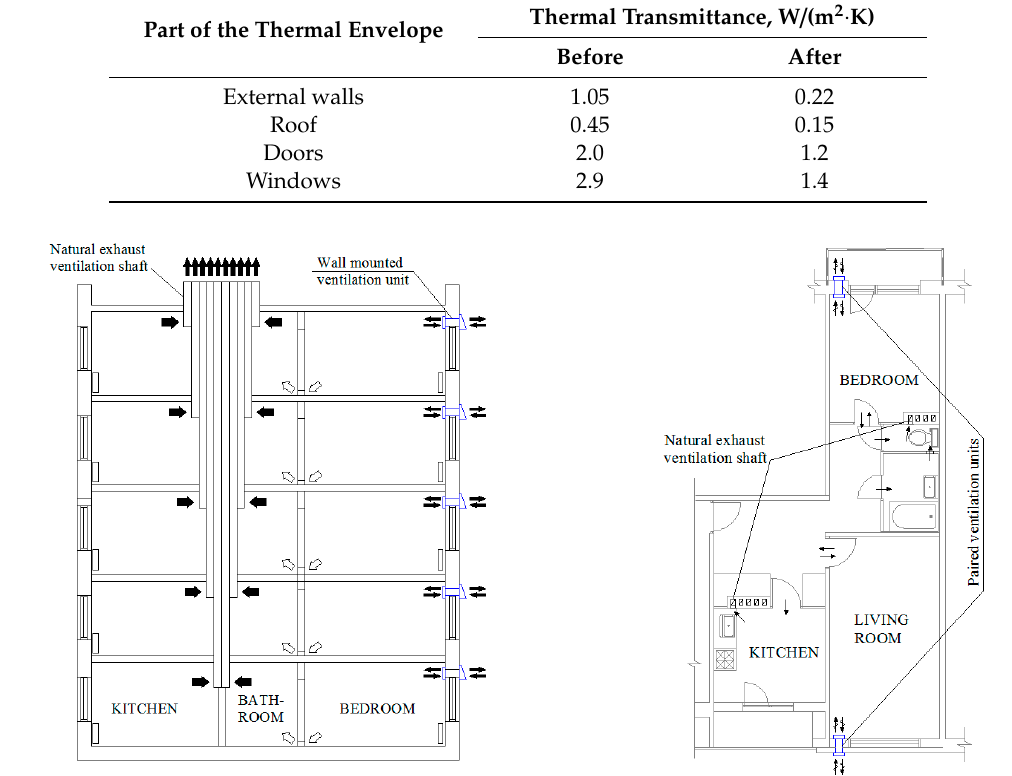
Table 1. Thermal transmittances of the envelope before and after retrofitting.